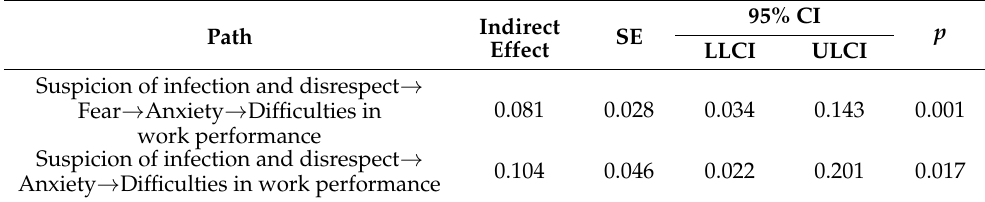
Table 3. Indirect effect of independent variables on Difficulties in work